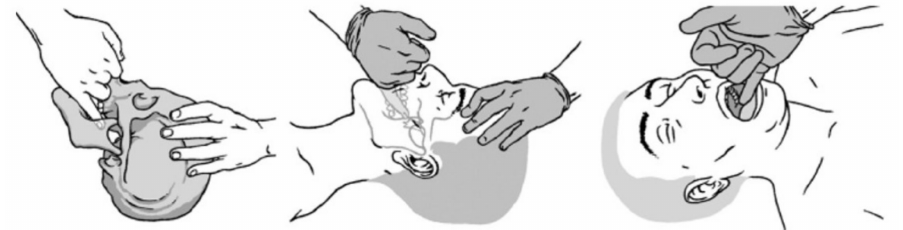
Figure 2. Active manual stimulation of the sphenopalatine ganglion. Reproduced from Jacq et al. BMC Complementary and Alternative Medicine (2017) 17:546; DOI